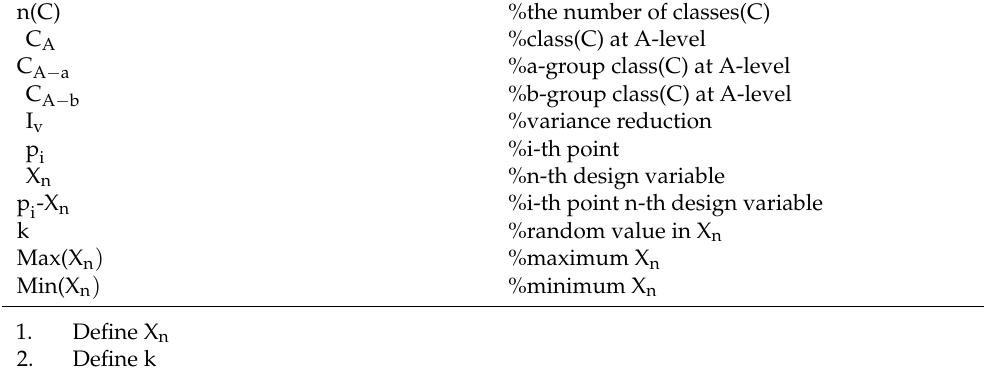
Table 2. CART pseudocode (summarized from